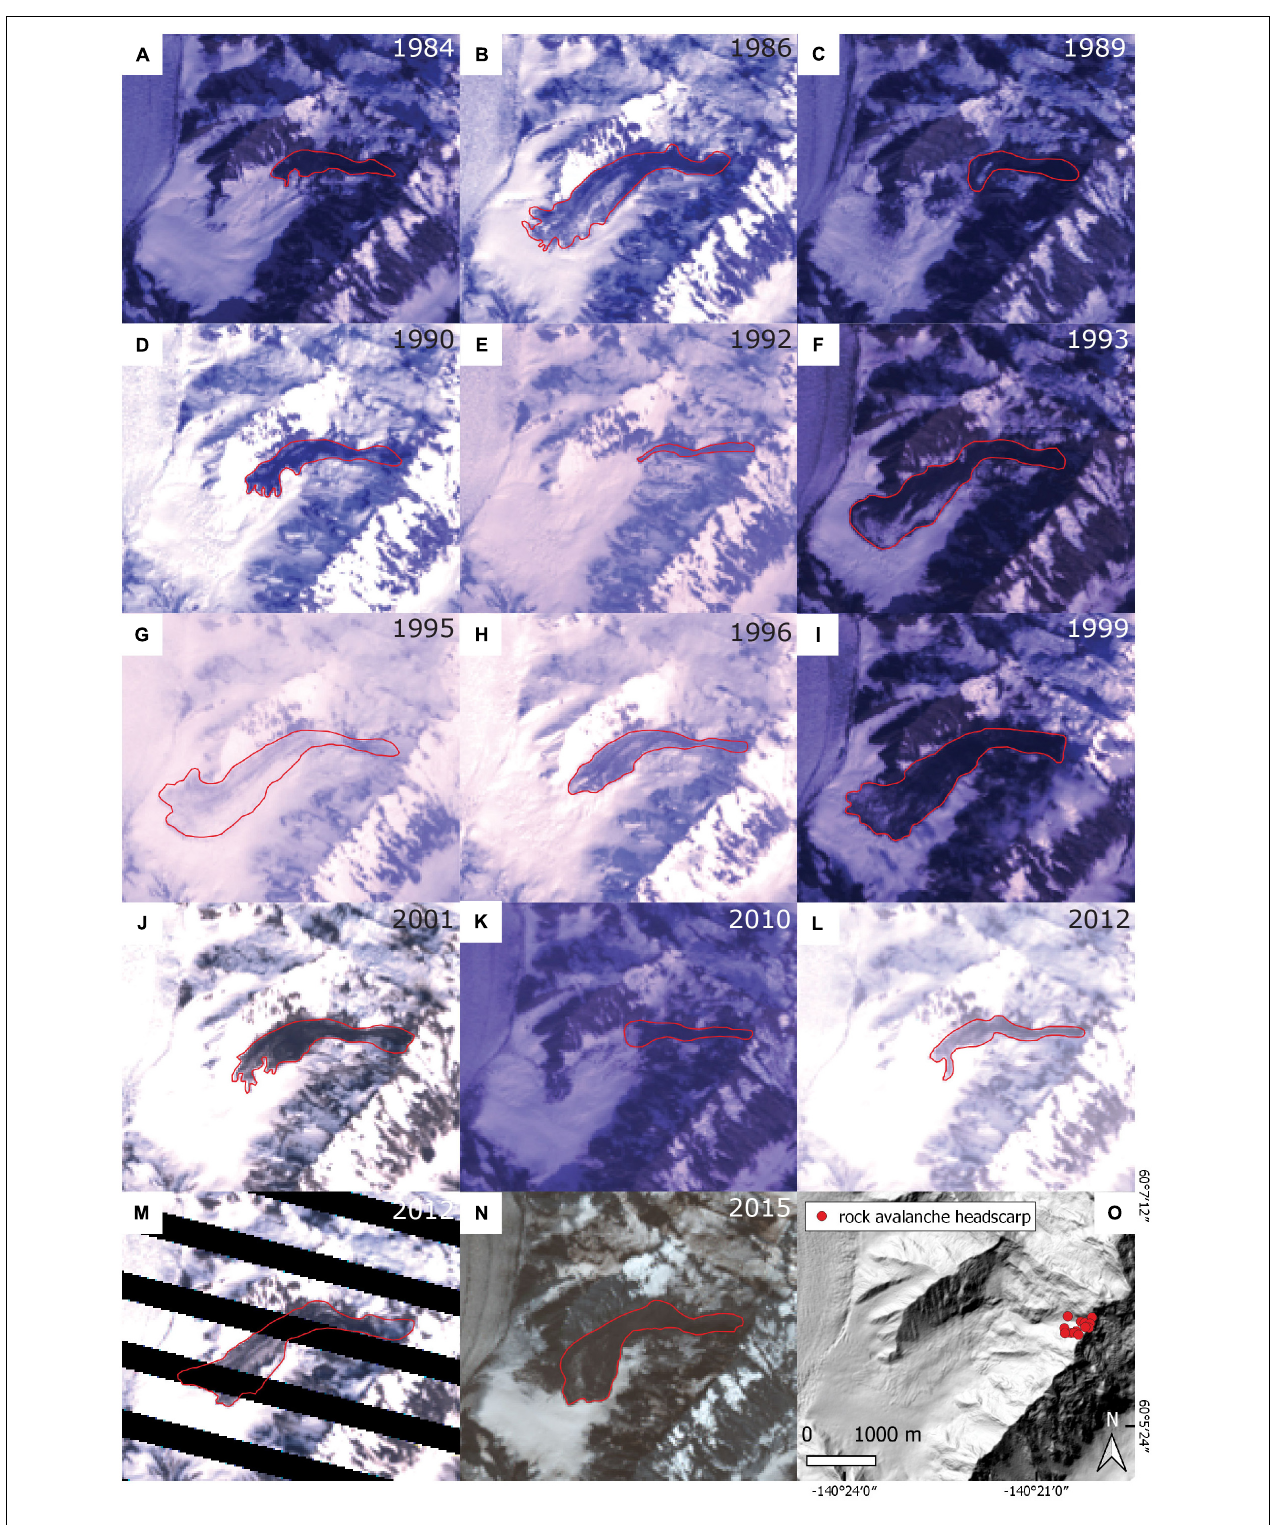
FIGURE 10 | Landsat imagery showing 14 mapped rock avalanches (cluster c12) on Hitchcock Glacier in the Saint Elias Mountains. Rock avalanches occurred in (A) 1984 (RA 2), (B) 1986 (RA 8), (C) 1989 (RA 24), (D) 1990 (RA 25), (E) 1992 (RA 37), (F) 1993 (RA 43), (G) 1995 (RA 51), (H) 1996 (RA 62), (I) 1999 (RA 78), (J) 2001 (RA 86), (K) 2010 (RA 149), (L,M) 2012 (RA 158 and RA 159), and (N) 2015 (RA 182). (O) Hillshade (derived from a 5 m digital elevation model (DEM; U.S. Geological Survey, 2012) of Hitchcock Glacier and the surrounding area showing the locations of rock avalanche headscarps. Note: the IFSAR-derived DEM was acquired in 2012 and the deposit of RA 159 is apparent in the